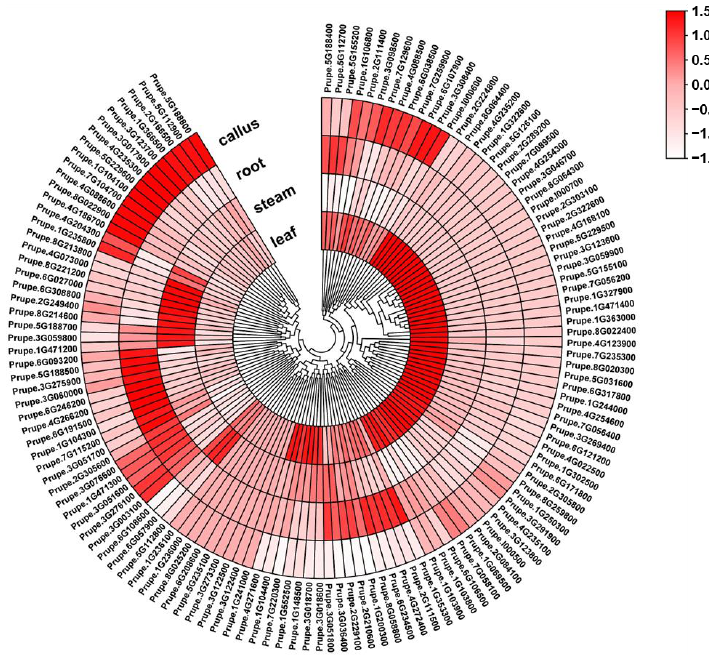
Figure 3. Expression profile of PpABC genes in different tissues of peach. The FPKM values were used to generate a heatmap with hierarchical clustering analysis. The color scale displaying the expression levels ( − 1.5 to 1.5) was indicated.